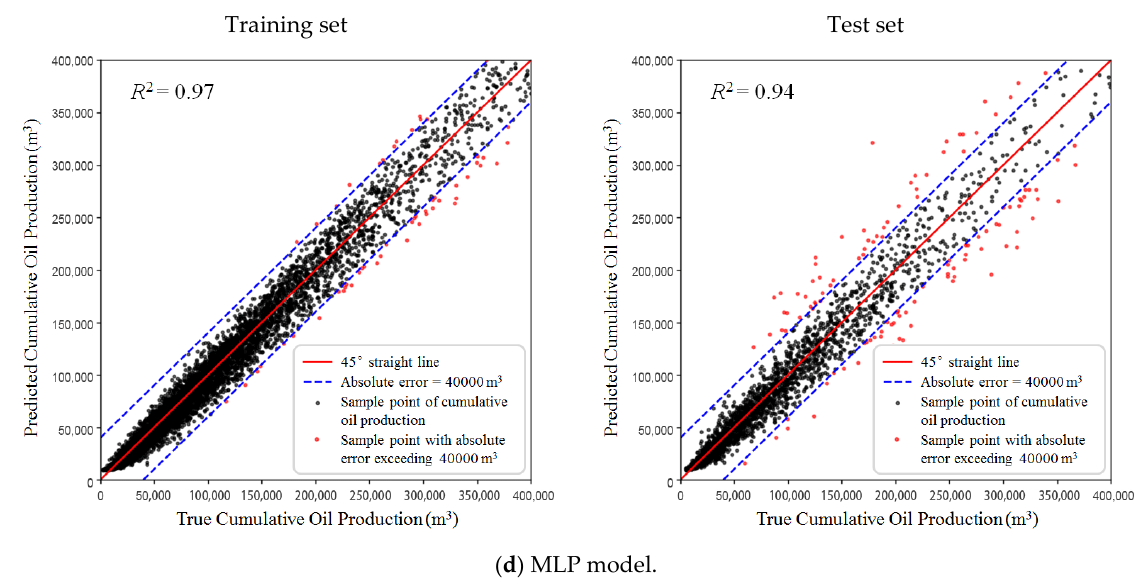
Figure 10. Performance of the training set ( left ) and test set ( right ). Table 3. Comparison of prediction performance of various models.